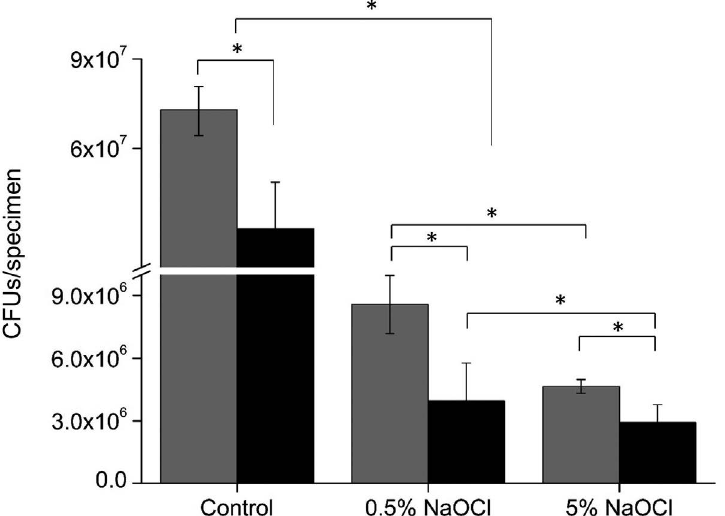
Figure 4- CFU assay with NaOCl treatment. E. faecalis were cultured in BHI without DNase (gray bar) or with DNase (black bar) for 2 days, and then the biofilms were treated with 0.5 or 5% of NaOCl for 5 minutes. Control: cultured only in BHI for 2 days without NaOCl treatment. *Statistical significance was determined at